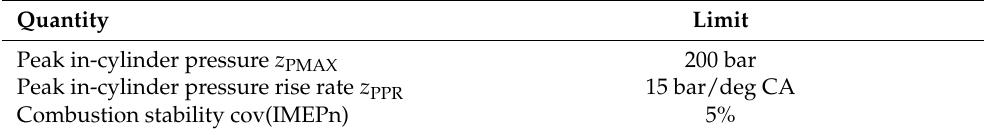
Table 4. Limits for safe and stable RCCI operation.